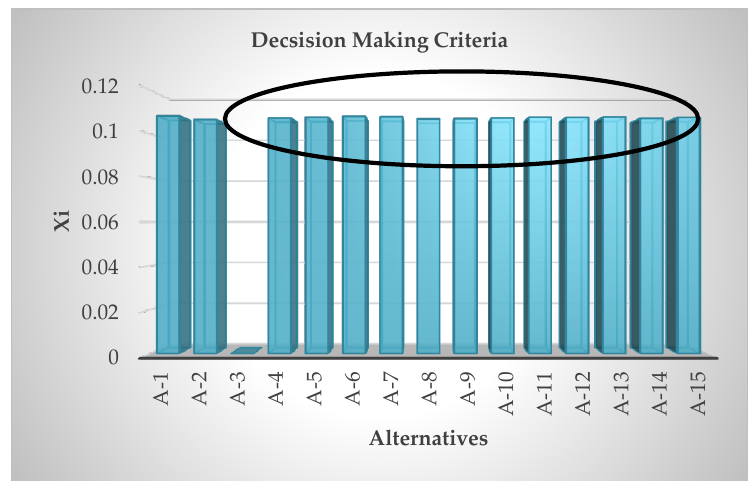
Figure 14. Decsision-making criteria based on equally weighted indices scenario.